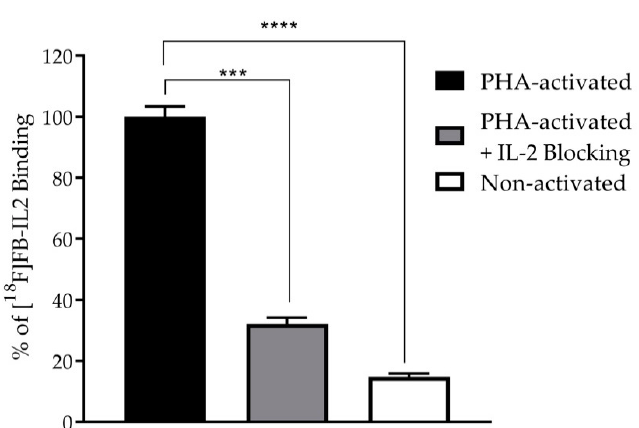
Figure 2. The electrospray ionization-mass spectrometry (ESI-MS) profile of unlabeled IL-2 and FB-IL-2. ( A ) The positive ion mode ESI-MS spectra of IL-2 unlabeled, showing different mass/charge ( m / z ) ratios from +8 to +17 charges; the deconvoluted mass of unlabeled IL-2 was 15,328 ± 2 Da and that matched the theoretical expected mass 15,330 Da. ( B ) Positive ion mode ESI-MS spectra of decayed labelled FB-IL-2 suggest a different degree of conjugation; magnified charge state (+9 charge) region suggests IL-2 labelling with monoconjugation, diconjugation, triconjugation, tetraconjugation and pentaconjugation. Based on the relative intensity ratio, it indicates between 2–3 FB groups per IL-2 molecule are the most abundant coupling. Note: The labels on the mass spectra peaks +n, indicate the number of protons attached to the protein.